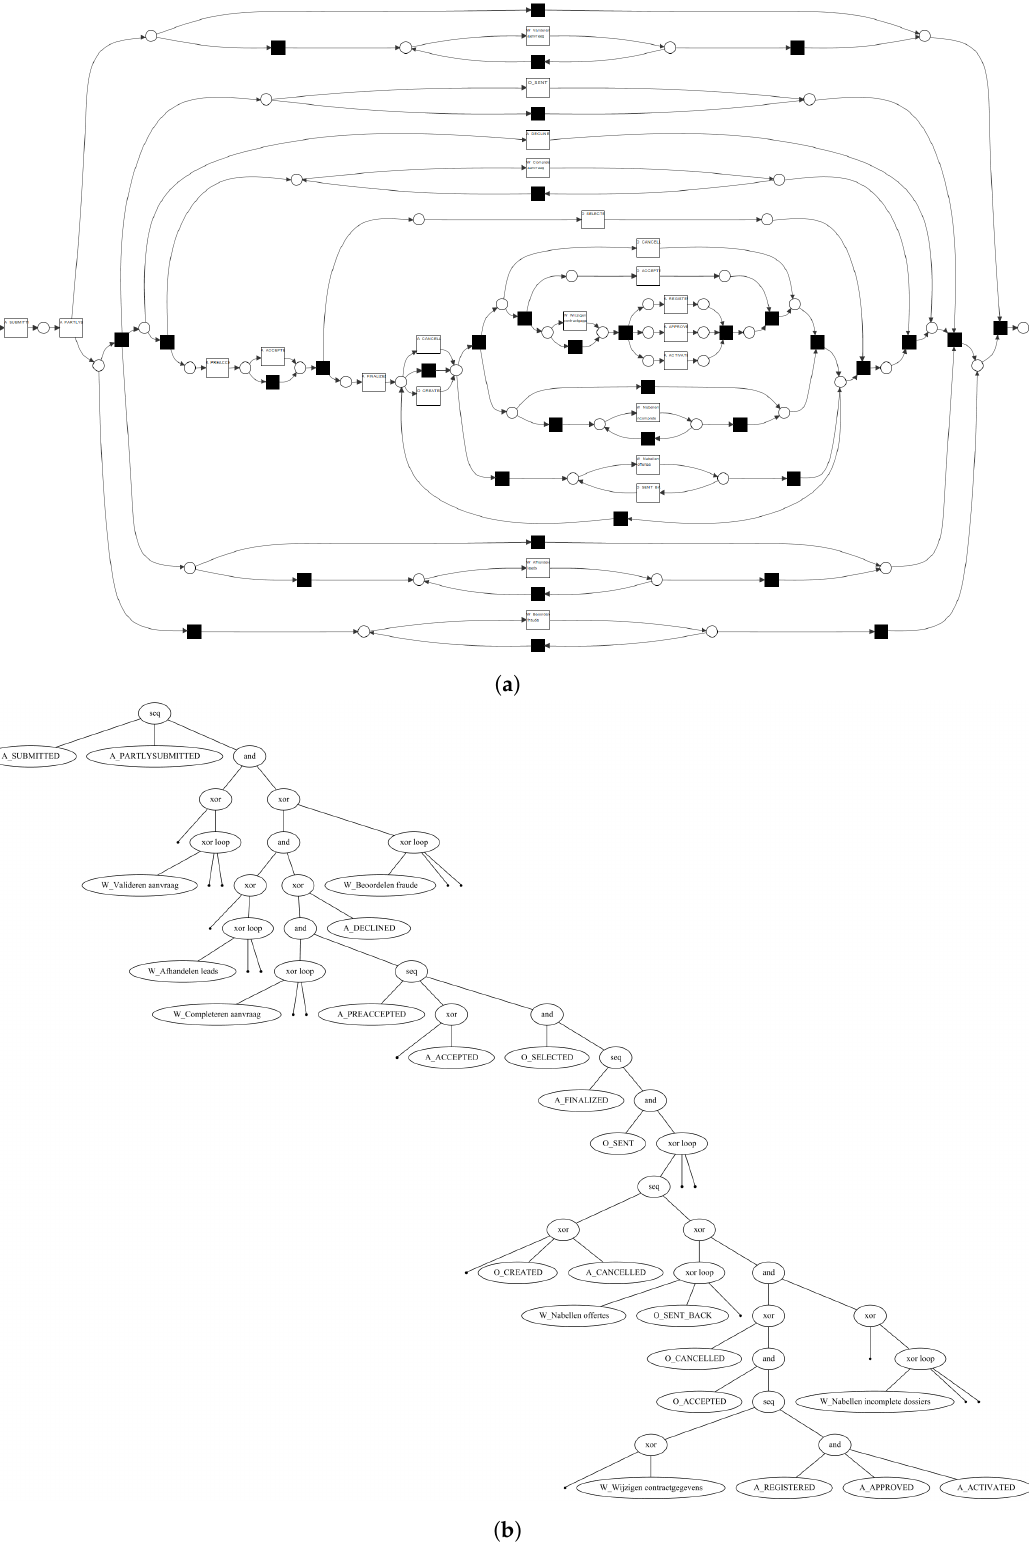
Figure 2. The same process model, obtained by applying the Inductive Miner [12] implementation of ProM [13] on a real event dataset [14], in different process modeling formalisms. Because of its hierarchical nature, the process tree formalism easily allows us to spot the main control-flow behavior. ( a ) The process, represented as a WF-net; ( b ) The process, represented as a process